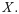
Principal component analysis.(A) Plot of the sorted eigenvalues of the covariance matrix associated with the data matrix X.Note that the eigenvalues begin to decay more slowly at about n= 30. (B) SVM sensitivity (top curve) and specificity as a function of the number of principal components used in the feature reduction procedure. Note the best result overall occurs utilising 22 principal components, but the best sensitivity occurs with 16 principal components.